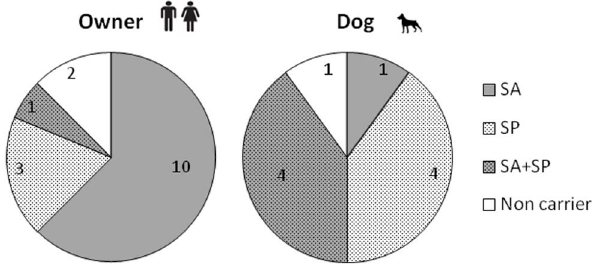
Figure 2. Distribution of investigated individuals (owners, dogs) related to the SA and/or SP carriage as a summary of the sampling year (T0–T4).